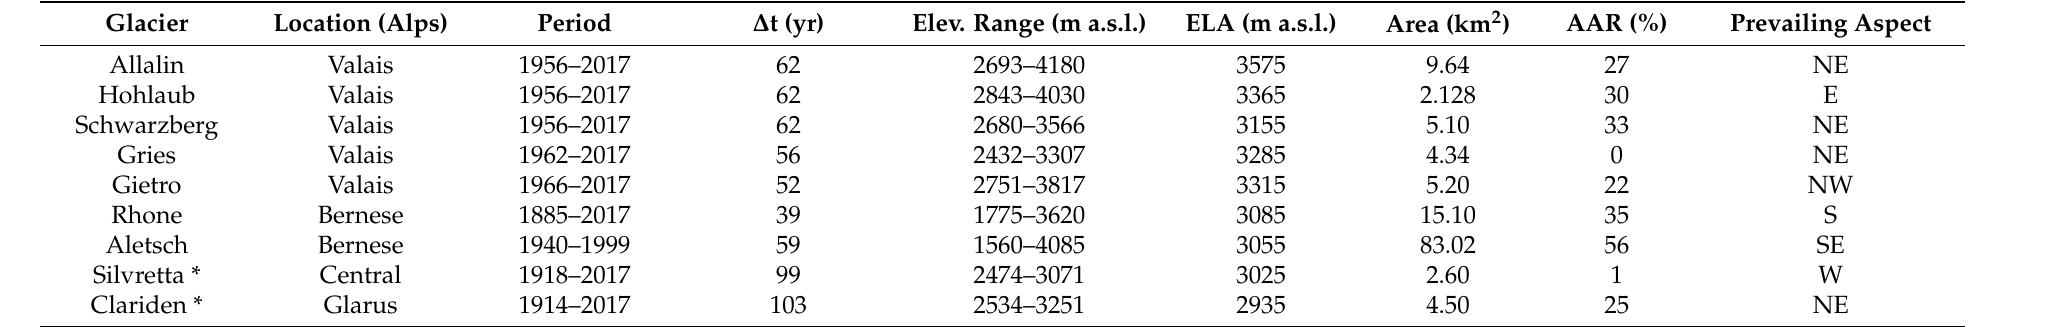
Table 1. Characteristics of the selected Swiss glaciers referring to the end of the observation period. Glaciers are ordered based on the time series length ( ∆ t), elevation range (elev. range), equilibrium line altitude (ELA), area, accumulation area ratio (AAR), and the prevailing aspect. Rhone and Aletsch are the two discontinuous time series, indicating seasonal data are not available for the entire period (Source: